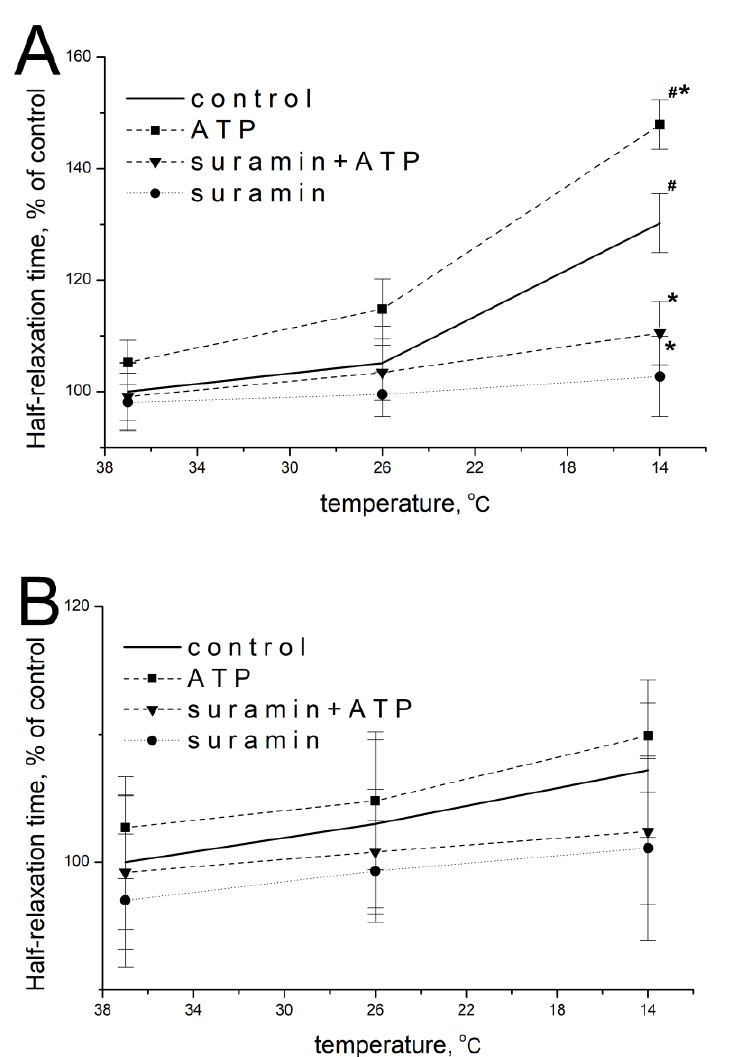
Figure 2. Effect of ATP (100 µM) and suramin (100 µM) on the half-relaxation time of m. soleus ( A ) and m. EDL ( B ) at different temperature regimes ( n = 12–18). # p < 0.05 from the effect at 37 ◦ C, and m. EDL ( B ) at different temperature regimes (n = 12 – 18). # p < 0.05 from the effect at 37 °C, * p < 0.05 from control. * p < 0.05 from